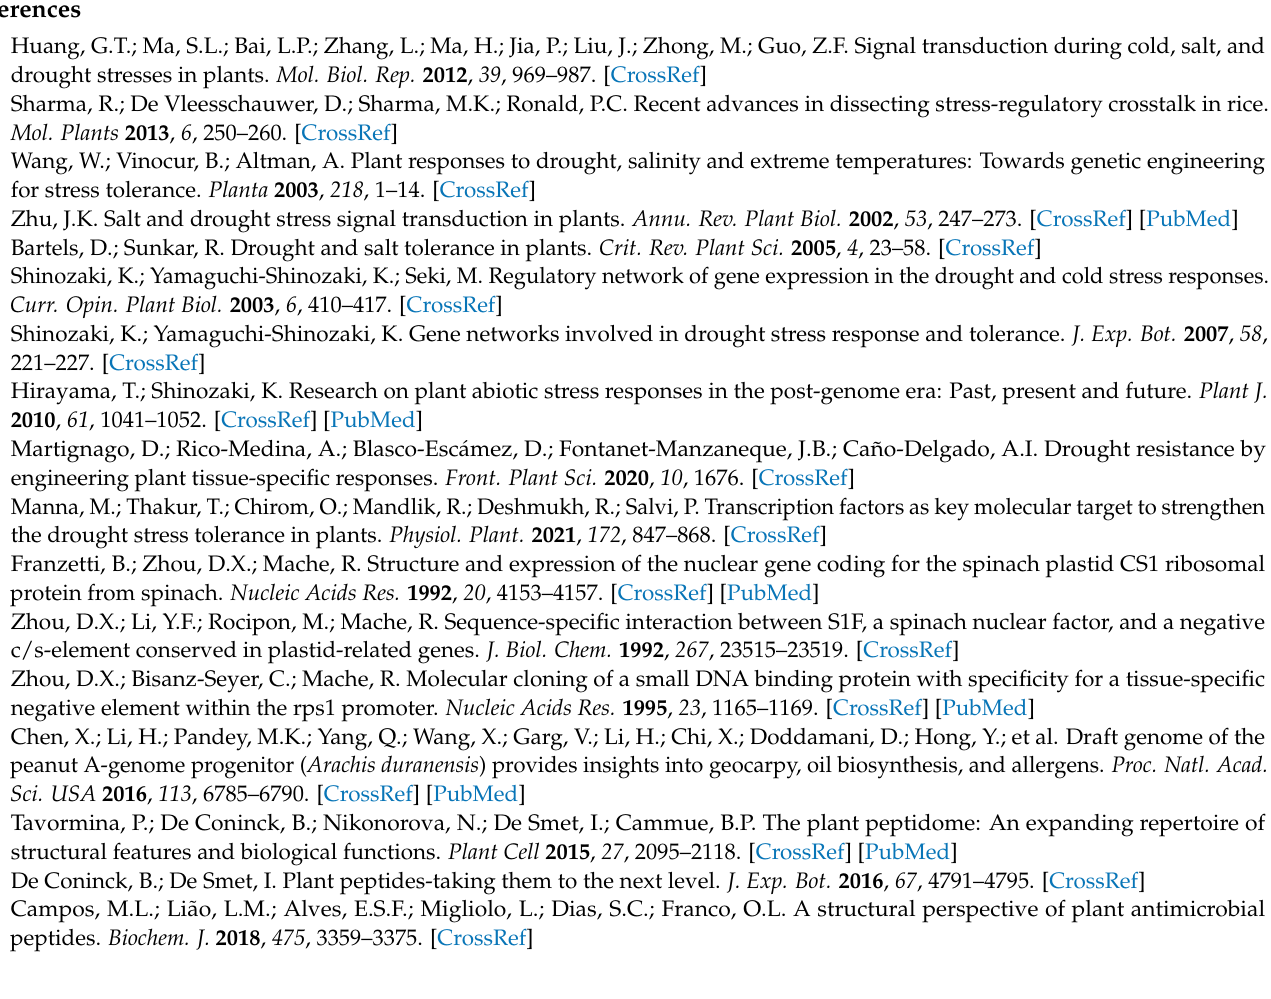
(BDM-PUB), Table S2: Primers used for plasmid construction, Table S3: Primers used to perform quantitative real-time PCR